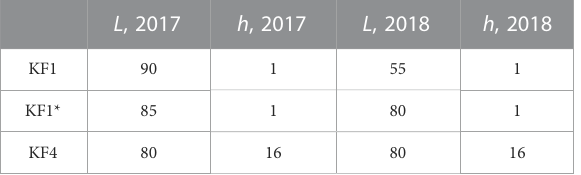
TABLE 1 Hyperparameters estimates from 10-fold cross validation for the models (KF1), (KF1*),